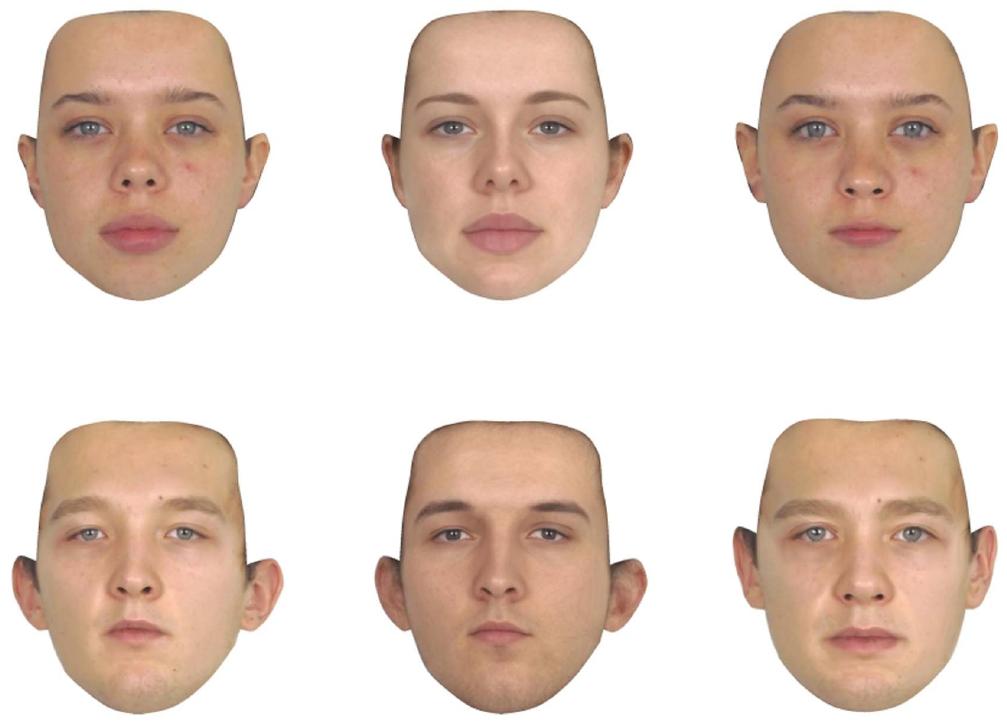
Figure 1. Examples of original (left), shape-only (centre), and surface-only (right) versions of female (top row) and male (bottom row) faces used in the study. Shape-only versions were manufactured by warping a prototype with the average color and texture information for the sample into the shape of each individual face. Surface-only versions were manufactured by warping each individual face into the average shape for the entire